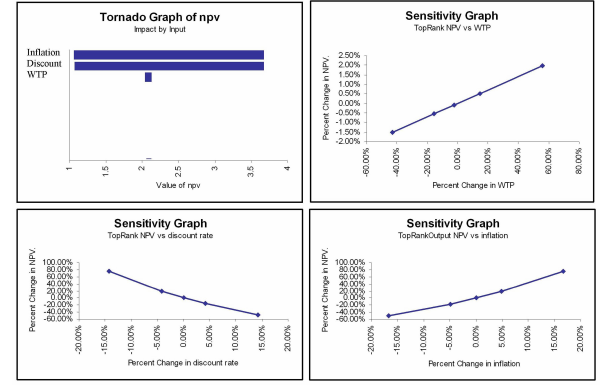
Figure 8. Sensitivity